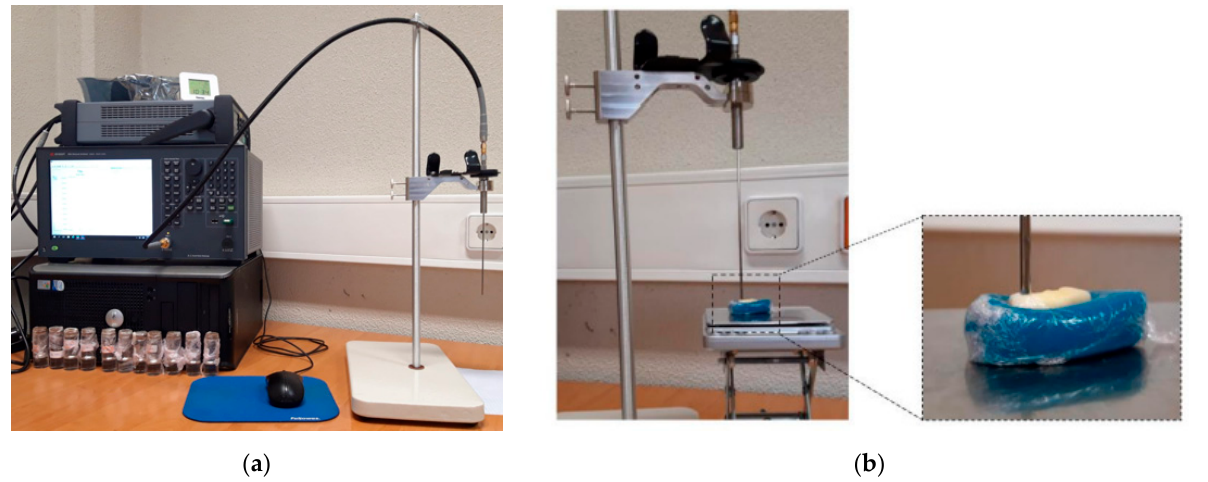
Figure 1. Experimental set-up: ( a ) measurement equipment; ( b ) tooth position during the measurement. Sample is supported by the plasticine holder in order to adjust the measurement site to the probe surface.